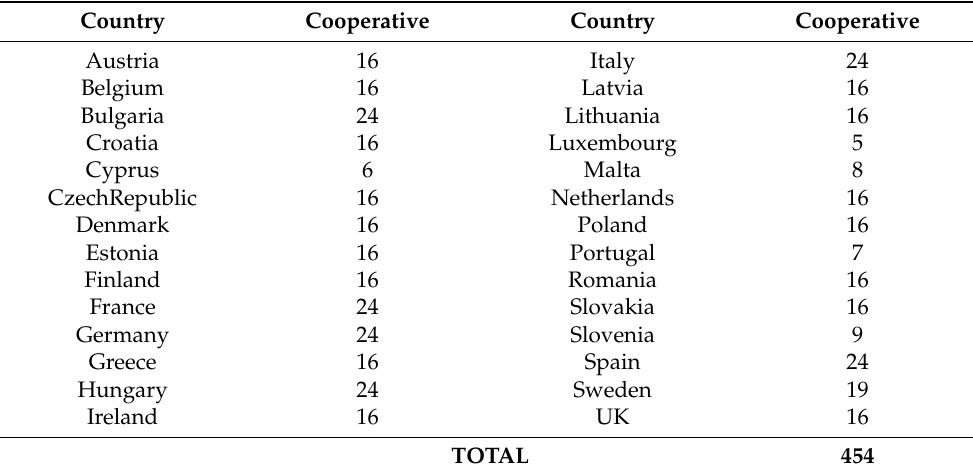
Table 1. Sample of cooperatives by EU country (28). Source: Own development.